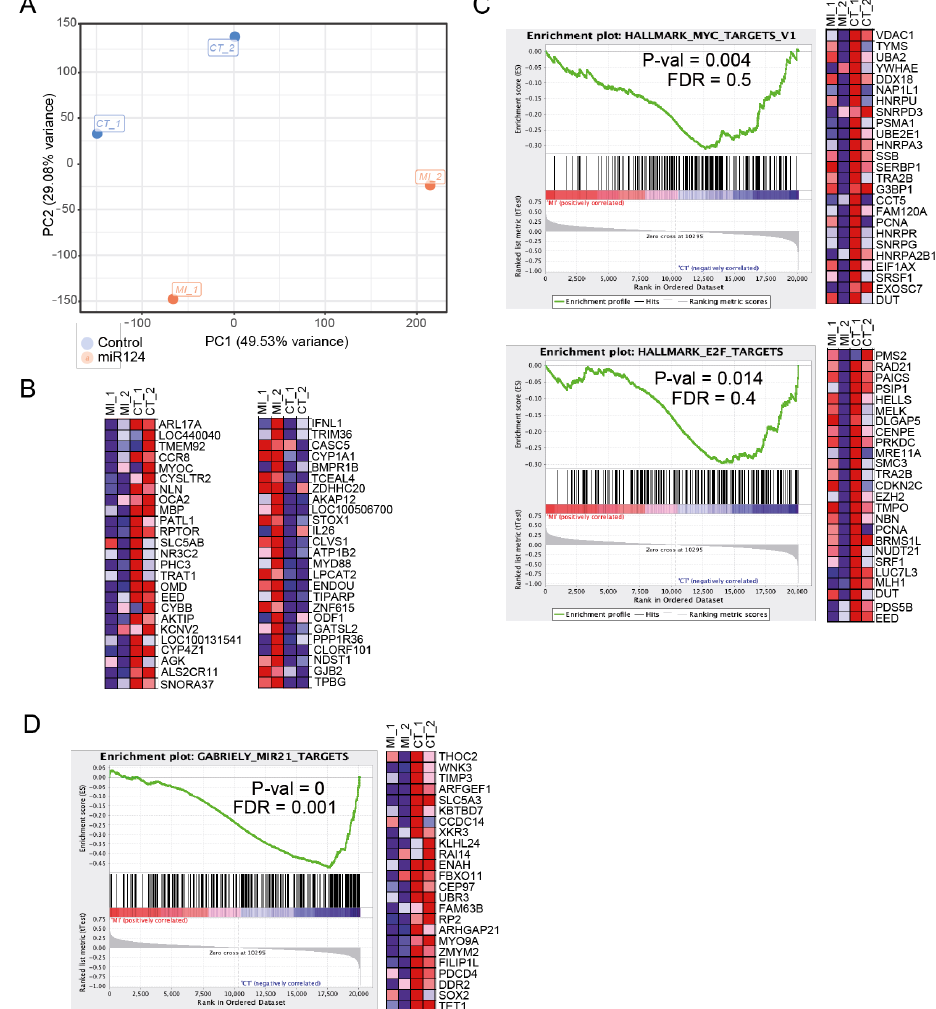
Figure 3. Transcriptional analysis of control and miR-124 transduced CTCL. ( A ) Principal Component Analysis of gene expression in control (non-transduced) CTCL cell lines (CT) versus miR-124-transduced (MI) CTCL cell lines; ( B ) heatmap showing the top di ff erentially expressed genes (upregulated, in red or downregulated, in blue) comparing miR-124-transduced with control non-transduced cells. ( C , D ) Gene Set Enrichment Analysis of genes downregulated following miR-124 expression identified a significant association with genes in the MYC and E2F pathways ( C ) and also with genes downregulated by ectopic miR-21 expression ( D ). FDR, false discovery